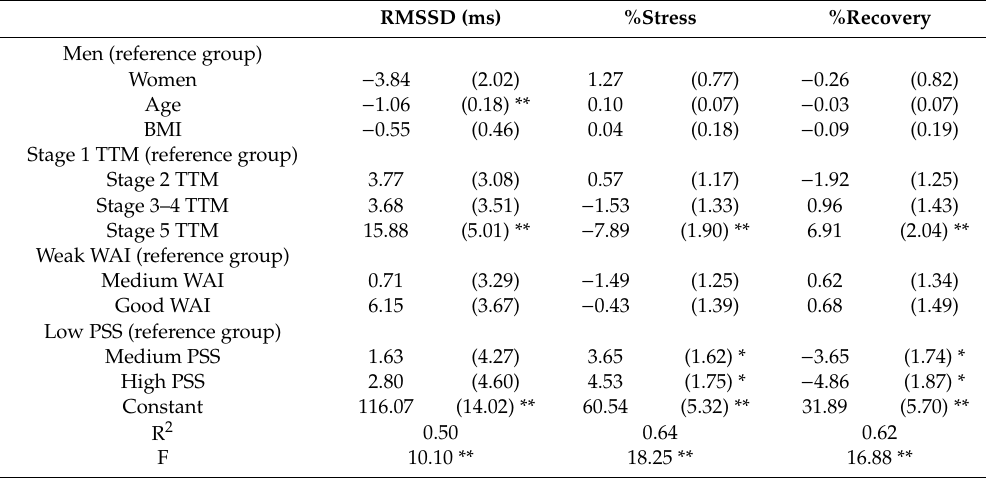
Table 5. Influence of TTM, WAI, and PSS classifications on physiological